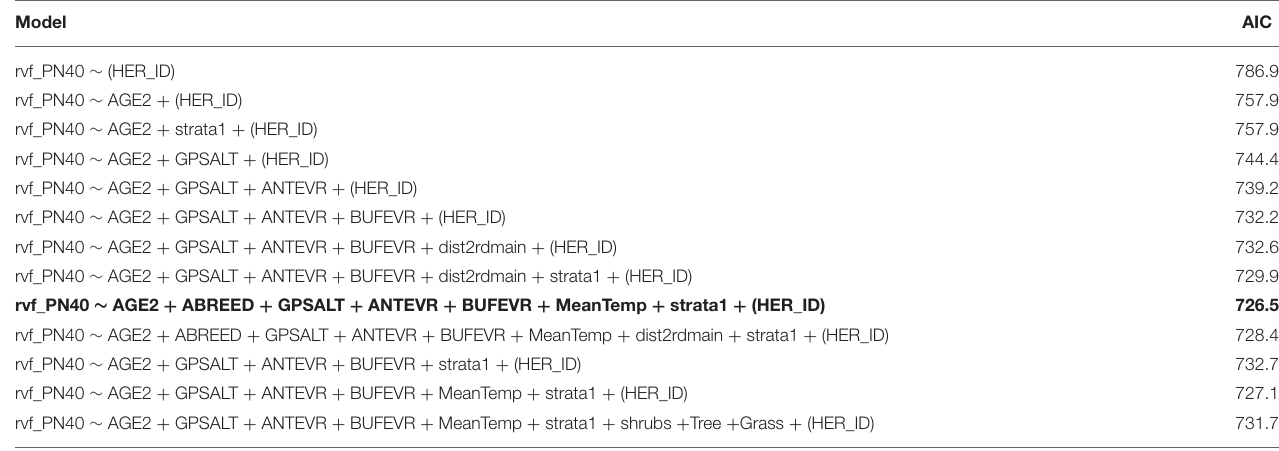
TABLE 3 | Stepwise forward selection of final hierarchical multivariable logistic regression model (with herd fitted as a random effect). Model